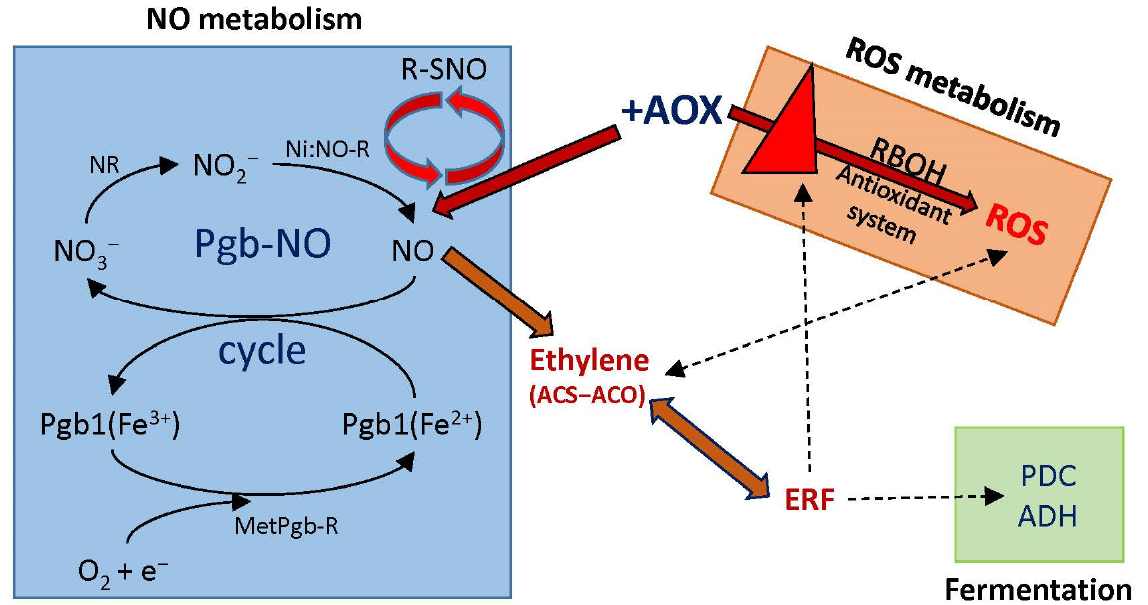
Figure 8. A model for the role of AOX in the activation and regulation of NO, ROS, and ethylene to improve tobacco resistance to hypoxia. Abbreviations: NR, nitrate reductase; Ni:NO-R, nitrite:NO reductase activity of electron transport components; MetPgb-R, reductase of metphytoglobin; PDC, pyruvate decarboxylase; ADH, alcohol dehydrogenase; ERF, ethylene response factors.